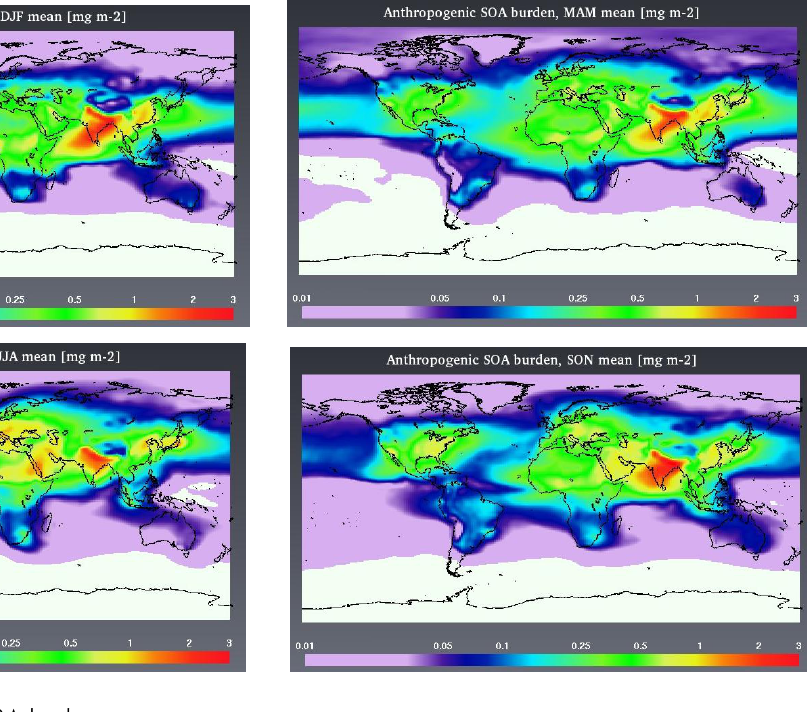
Fig. 3. Seasonal mean anthropogenic SOA burdens. Figure 3. Seasonal mean anthropogenic SOA burdens Figure 3. Seasonal mean anthropogenic SOA burdens